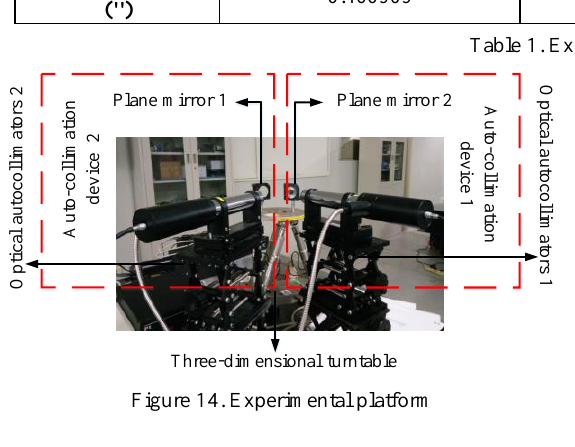
Figure 14. Experimental platform